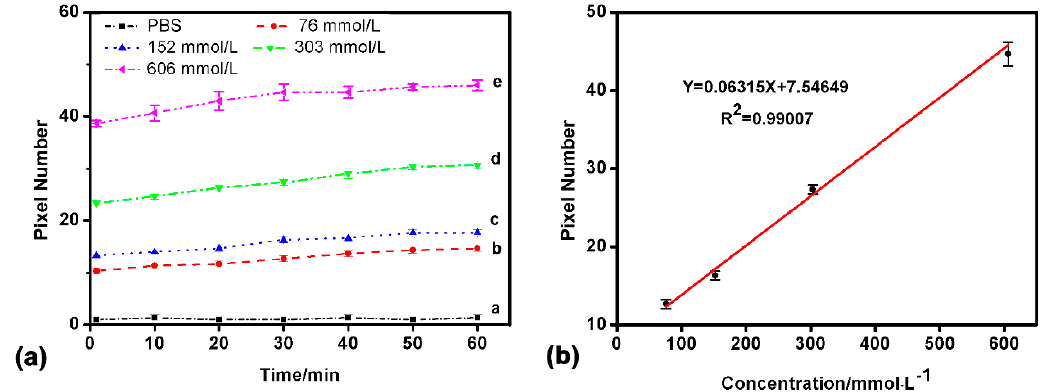
Figure 4. SPR detection results of the bovine serum albumin (BSA) adsorption. ( a ) The difference of the SPR response of 30 min was just about 5% less than that of 60 min, and 20% larger than that just loading the sample. ( b ) The linear fitting relationship of BSA of different concentrations (76–606 mmol/L), R 2 = 0.99007 (repeat times n = 3). PBS: phosphate-buffered saline.